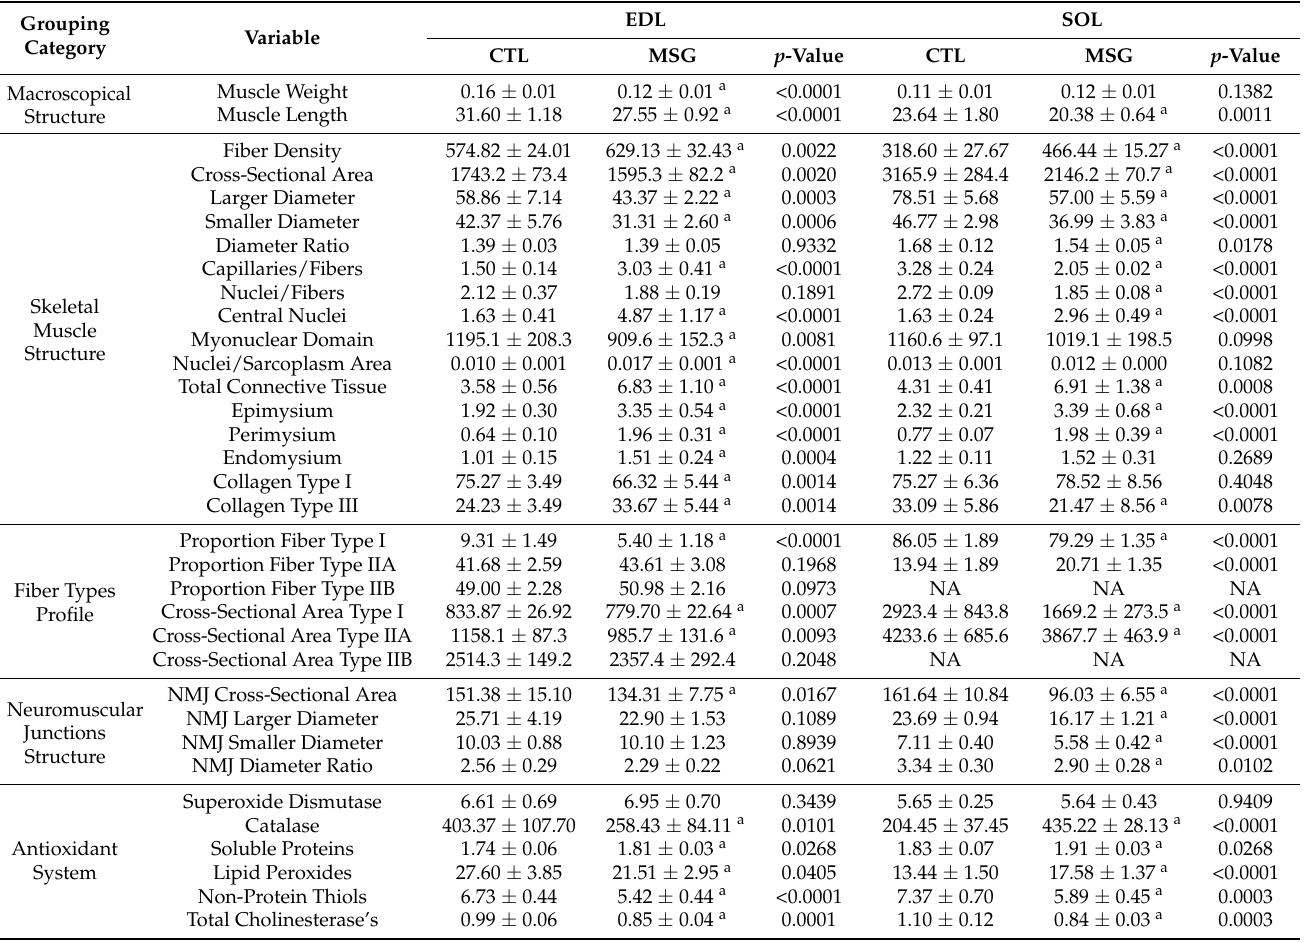
Table 1. Skeletal muscle structure, fiber types profile, and neuromuscular junctions structure from CTL and MSG animals to